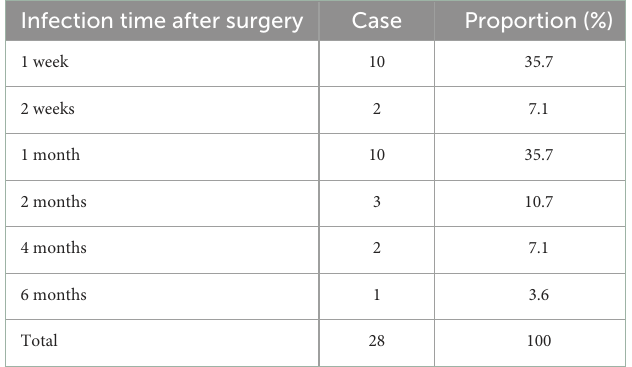
TABLE 2 Time distribution of postoperative